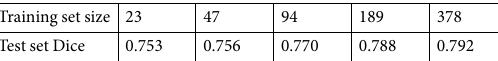
Table 6. Test Dice as a function of training set